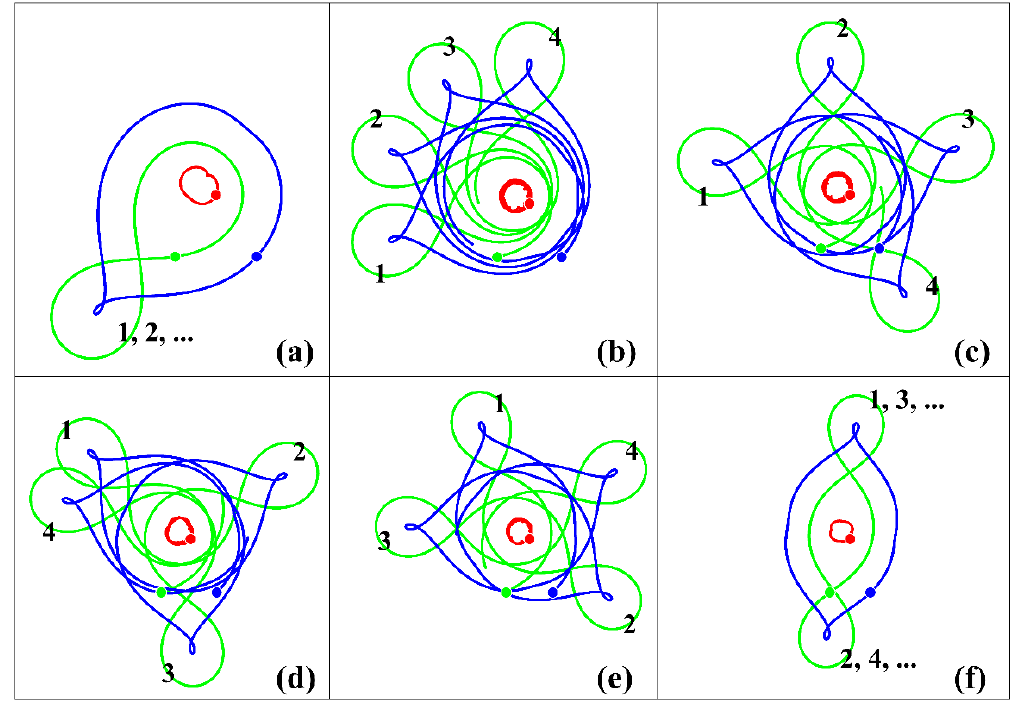
Figure 9. Illustration of the transition from one-mode to two-mode choreography of the Figure 7 with increasing of distance L = i · ∆ : i = 0, 1, ... , 5 for panels ( a ), ( b ), ... , ( f ). Numerals indicate the numbers of successively formed loops. All vortices begin their motion from the initial positions in the cyclonic direction.